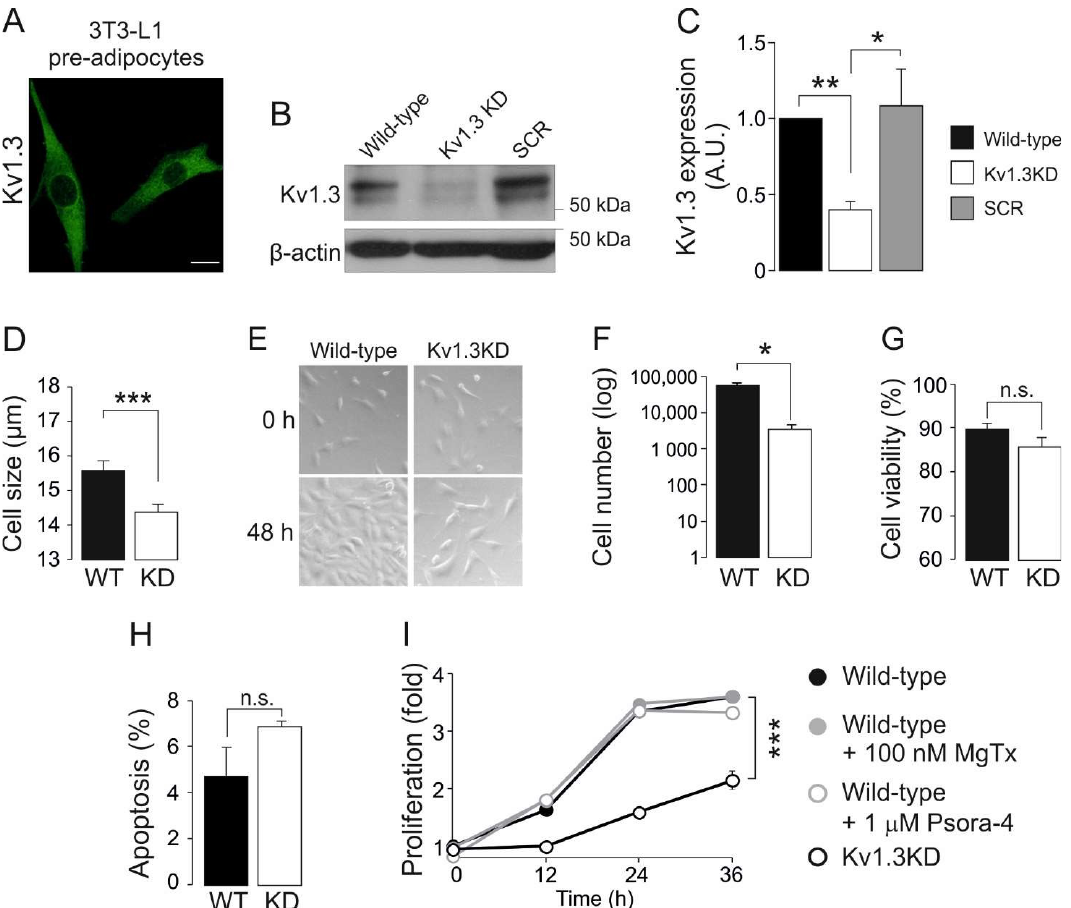
Figure 1 . Kv1.3 participates in the proliferation of preadipocytes. 3T3-L1 preadipocytes express Kv1.3, and genetic ablation of the channel alters cell proliferation. ( A ) Representative immunofluorescence confocal image of Kv1.3 in 3T3-L1 preadi- pocytes. The scale bar represents 20 μm. ( B ) Kv1.3 silencing in 3T3-L1 preadipocytes. Cells were infected with Kv1.3 shRNA (Kv1.3KD) or scramble shRNA (SCR) lentivirus. β-actin was used as a loading control. Noninfected 3T3-L1 cells were called wild-type (WT) cells. ( C ) Quantification of the efficiency of Kv1.3 silencing. The data are the mean ± SE ( n